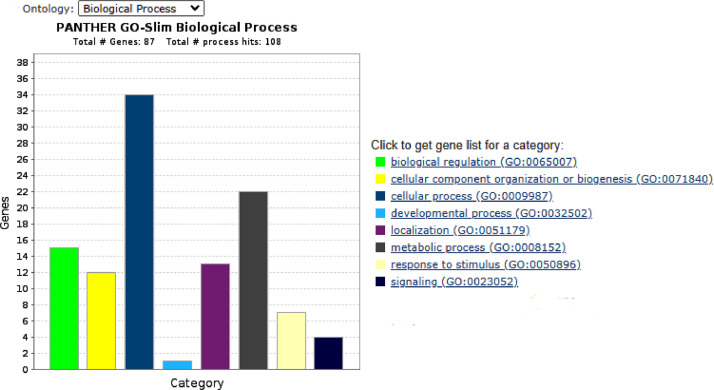
Gene Ontology (GO) classification of proteins with significant differences (One-way ANOVA, p < 0.05) between fish fed with distinct Met-supplemented diets, according to Biological Process.